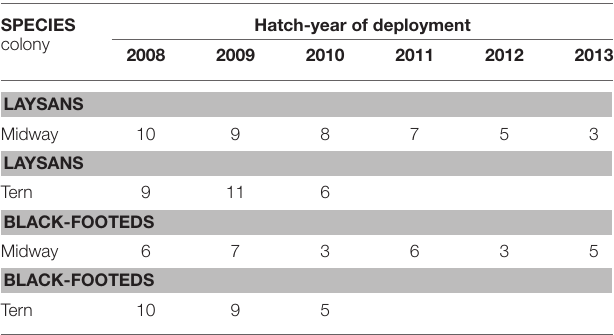
TABLE 1 | Number of individual GLS tracks used in analyses by